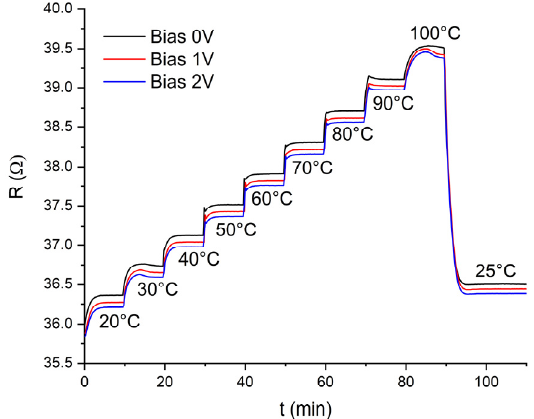
Figure 3. Response of the Gcvd sensor to temperature changes at different DC bias voltage levels.